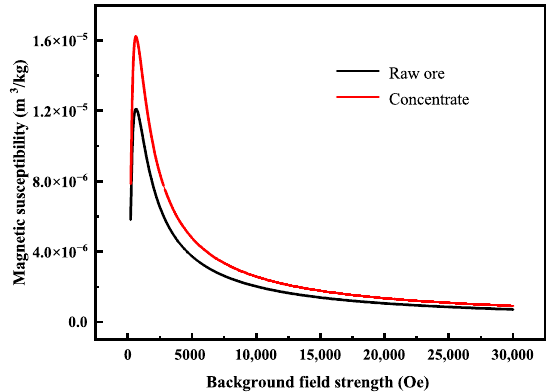
Figure 8. VSM specific magnetic susceptibility comparison